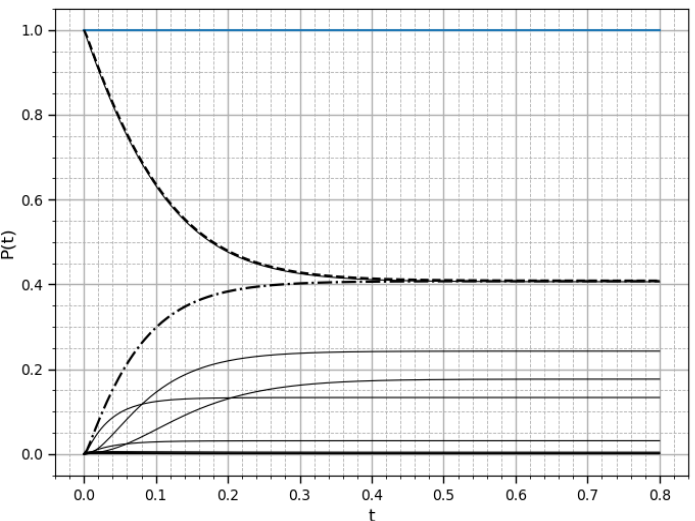
Figure 5. Dependencies of the probabilities on the time. Dashed and dotted line—the probability of losses; dashed line—the servicing device is idle, the buffer is empty.